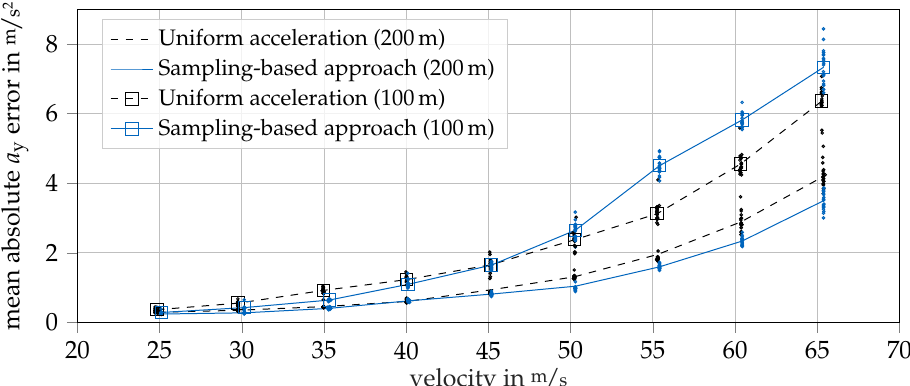
Figure 10. Mean absolute lateral acceleration control error per run (dots) using the sampling-based approach and the uniform acceleration approach with different ideally assumed detection ranges for the evasion maneuver shown in Figure 9. The lines represent the average values of the